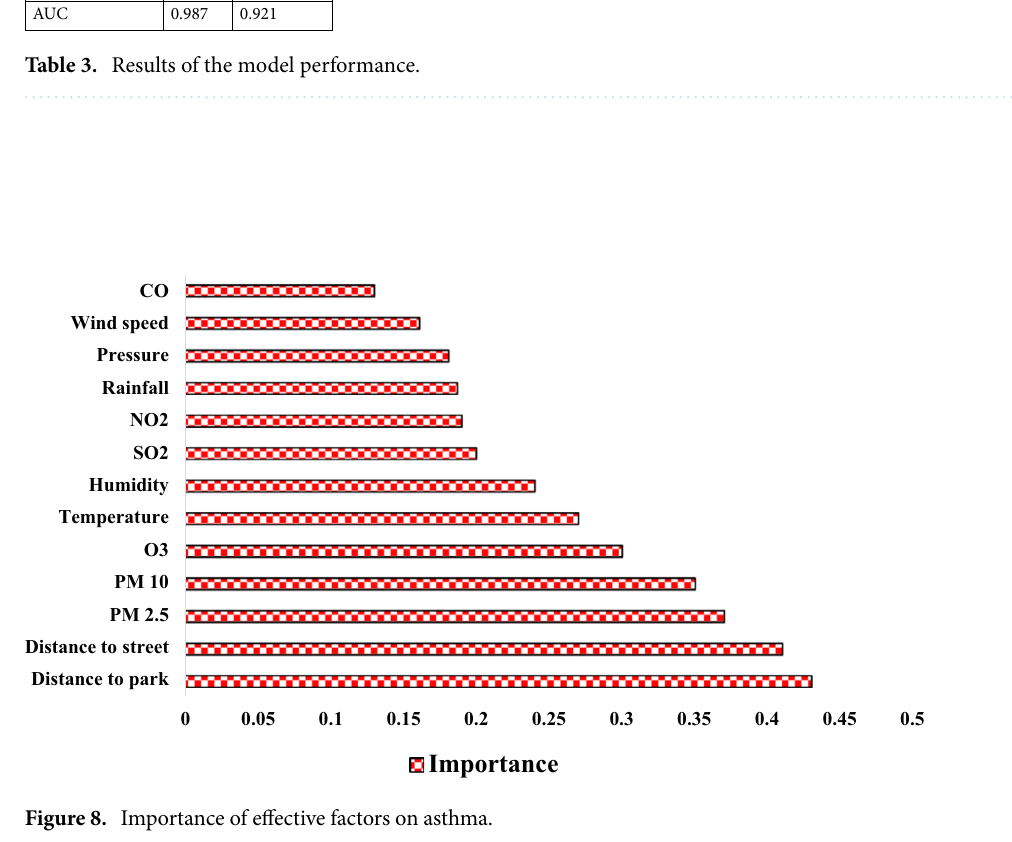
Figure 8. Importance of effective factors on